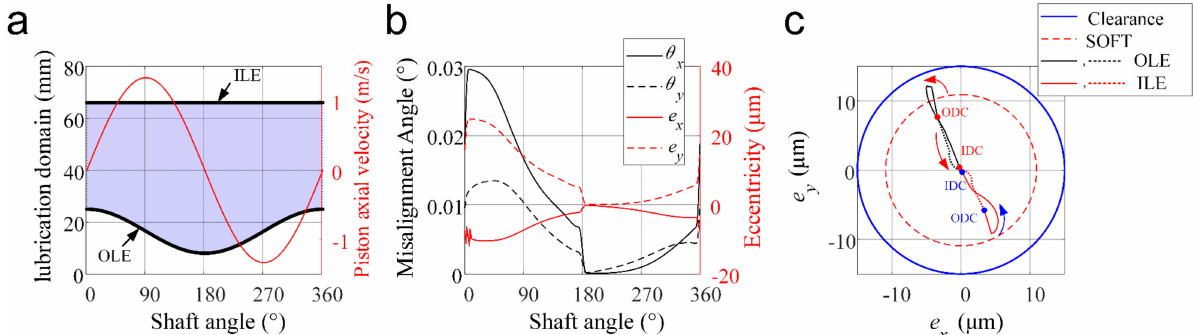
Figure 8. Dynamics results of the piston-cylinder pair: ( a ) Lubrication domain and the piston axial velocity, ( b ) Piston- oscillating eccentricities micro-motion, and ( c ) Center trajectories of OLE and ILE relative to the cylinder center.